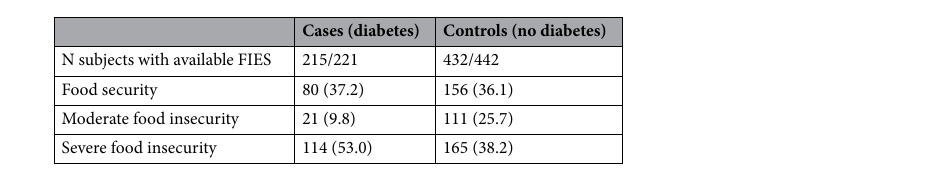
Table 2. Food insecurity according to FIES among cases and controls.